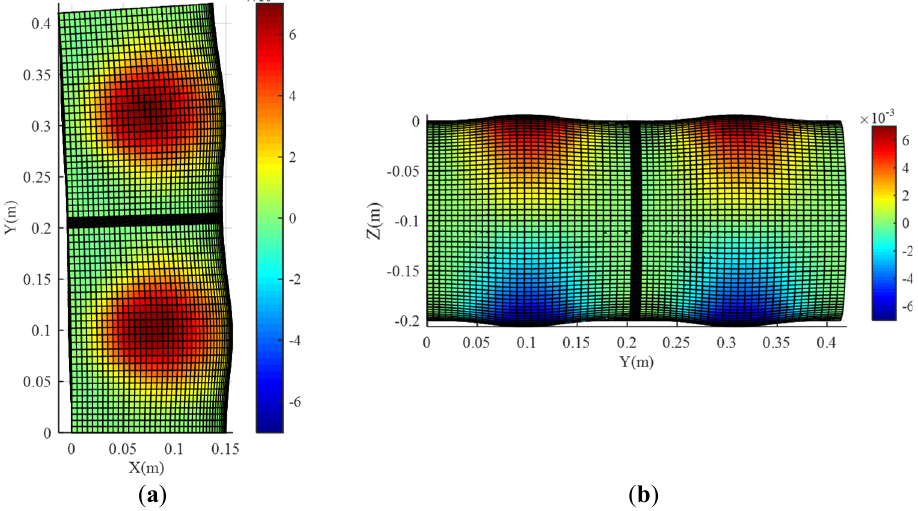
Figure 14. The deformation of two chambers under the pressure of 8 kPa . ( a ) Front view; ( b ) right view.